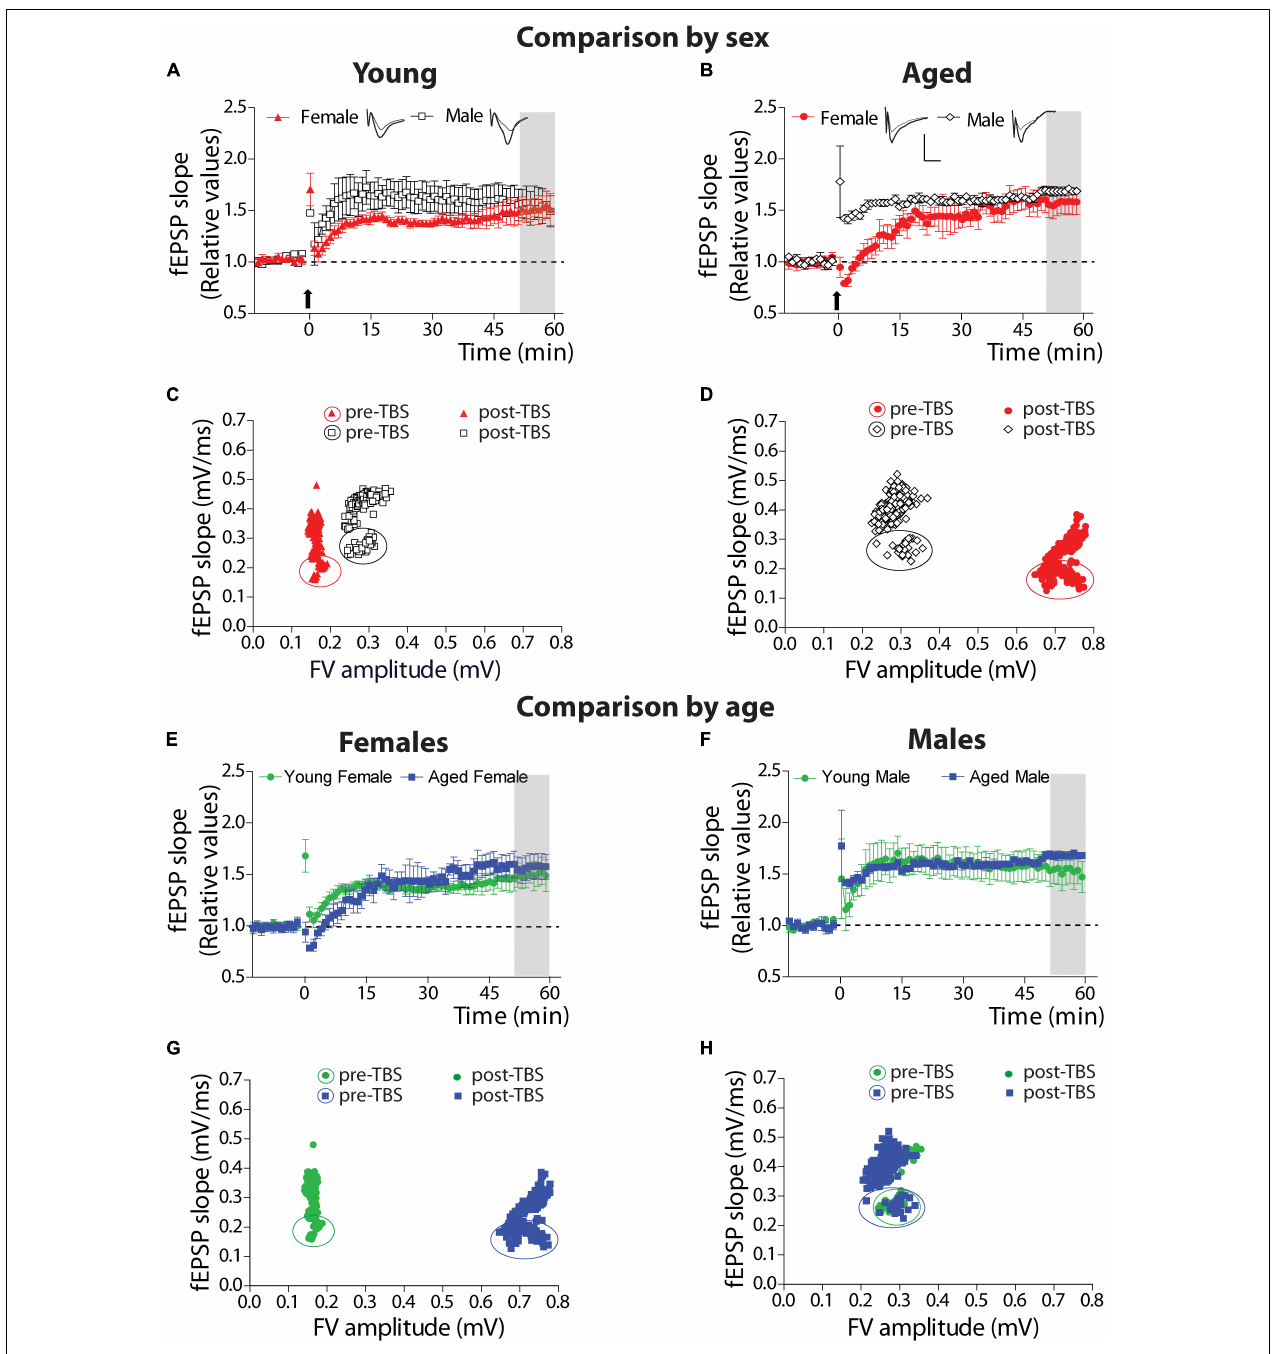
FIGURE 4 | Long-term synaptic plasticity parameters in young and aged female and male degus. (A–D) Comparison by sex. (A,B) Stimulation with theta-burst stimulation (TBS) induces long-term synaptic plasticity (LTP) in the hippocampal Schaffer collateral-CA1 of young female and male degus (A,C) and aged female and male degus (B,D) . The arrow indicates the moment of the TBS application. The insets show representative evoked fEPSPs before and after LTP induction (scale: 0.5 mV, 10 ms). (C,D) Correlation between fiber volley amplitude and fEPSP slope of the pre-TBS and post-TBS components of the averaged data used to calculate LTP. Enclosed symbols indicate the pre-TBS points. Comparison by age. The plot compares young and aged female degus (E,G) and young and aged male degus (F,H) . The correlation between the pre-and post-TBS components is shown for female degus (G) and male degus (H) . Data represent the mean ± SEM (21 slices from n = 7